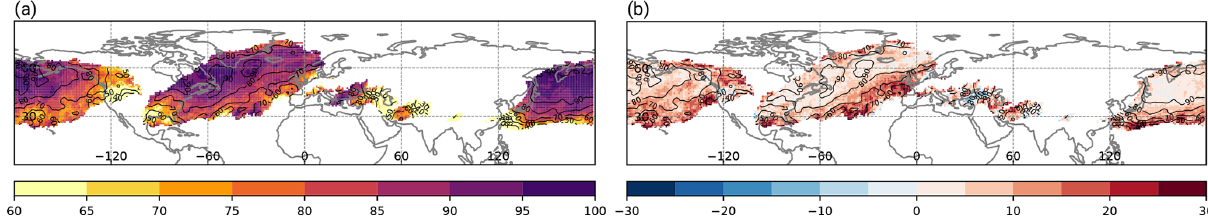
Figure 1. (a) Climatological matching frequency of WCB ascent footprints with extratropical cyclones during DJF as identified with the trajectory-based approach (black contours in %) and the CNN-based approach (shading in %). (b) Contours as in (a) , but shading denotes the difference in matching frequency (in %) between the CNN-based and trajectory-based